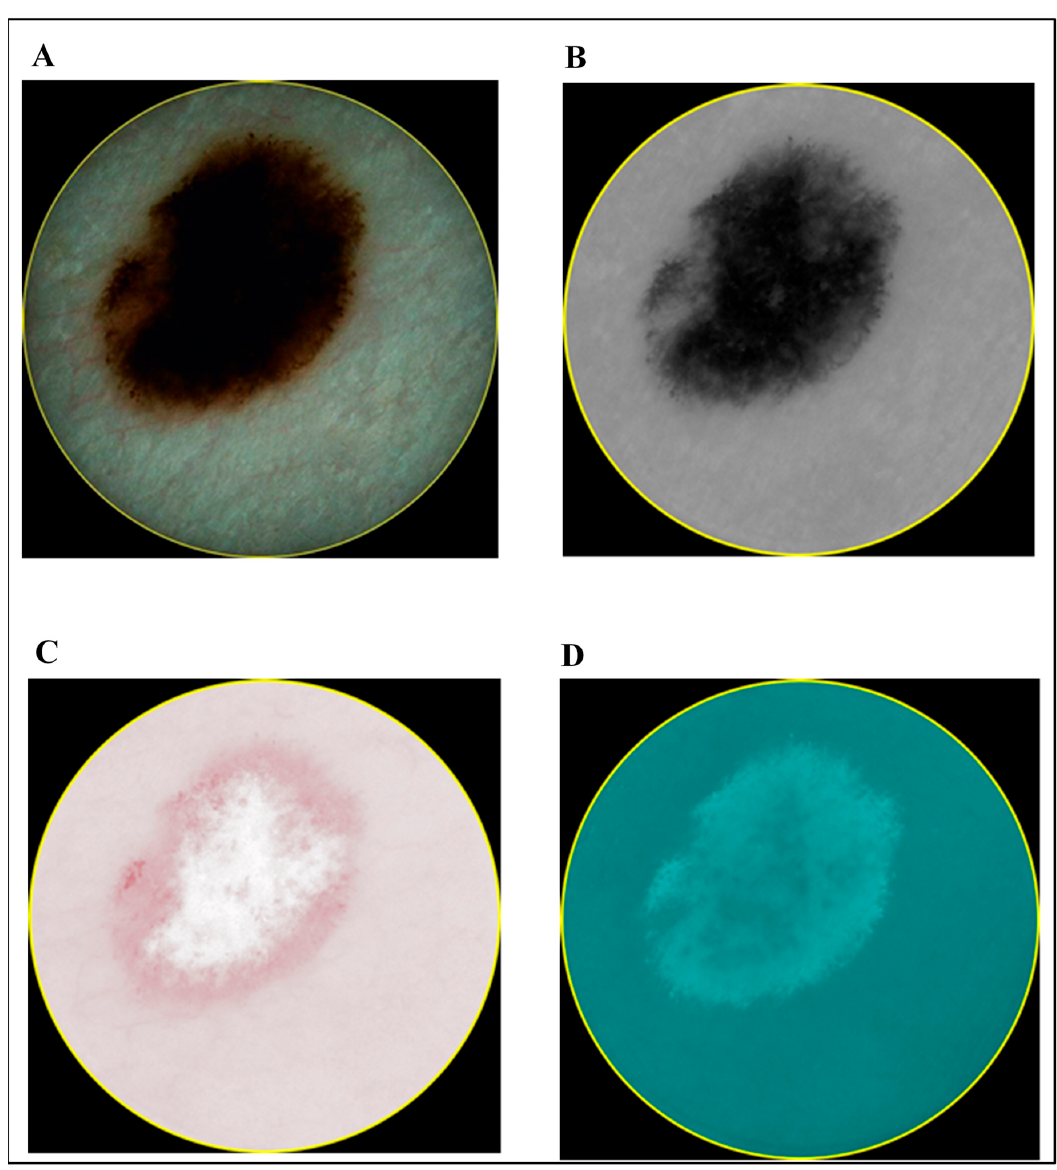
Figure 3. Images of cutaneous melanoma (CM): dermatoscopy ( A ) and different components acquired by spectrophotometry (melanin ( B ), blood ( C ) and collagen holes ( D )).